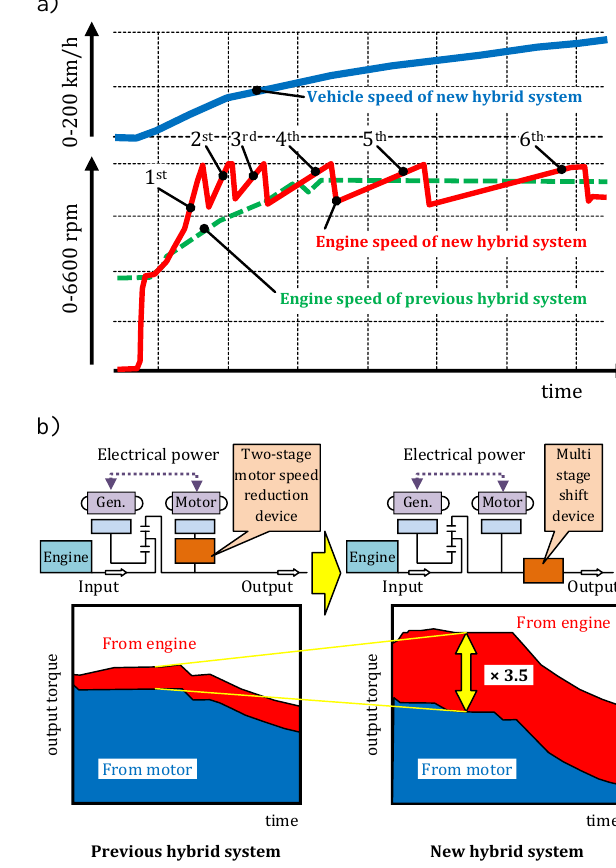
Fig. 3. Development of Multi Stage Hybrid System: a) wide-open throttle acceleration, b) improvement of output torque